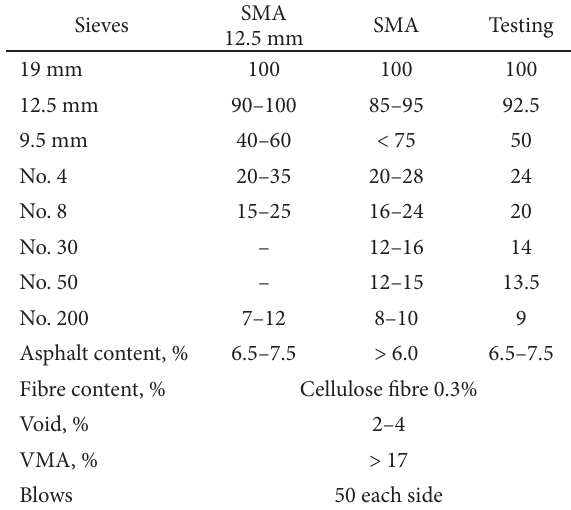
Table 3. Aggregate